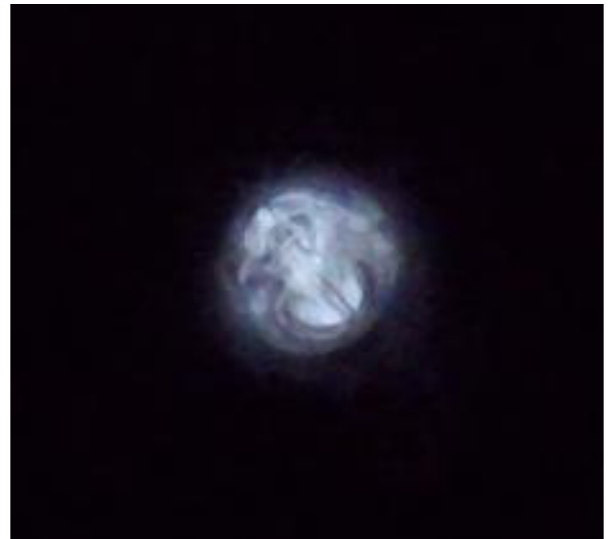
Fig. 9. Photograph of the actual Cherenkov light reaching the top of the tube during reactor operation.